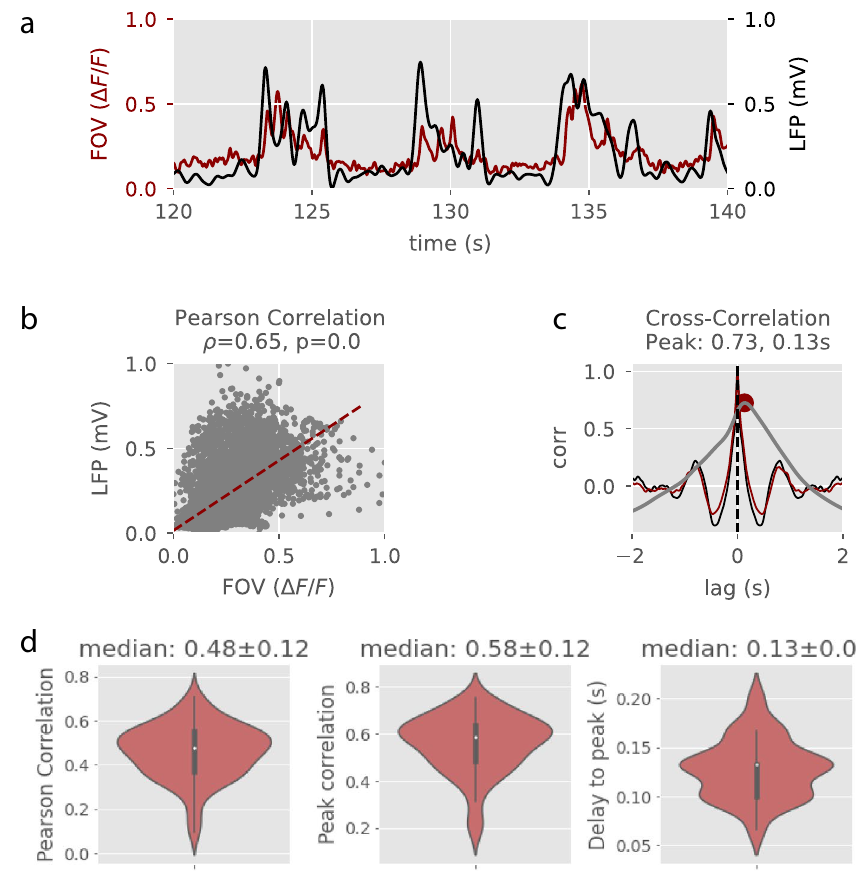
Figure 2. Correlation measures. a. Two-photon and LFP normalized signals during 20 seconds of an example recording at 1.5% isoflurane anesthesia. b. Pearson’s correlation. c. Auto- and cross-correlation of LFP (black trace) and FOV (red trace) signals. The cross-correlation (grey trace) peak is depicted with a red dot. d. From left to right, median values of the Pearson’s correlation, the cross-correlation peak and delay to the cross- correlation peak across n = 67 recordings (8